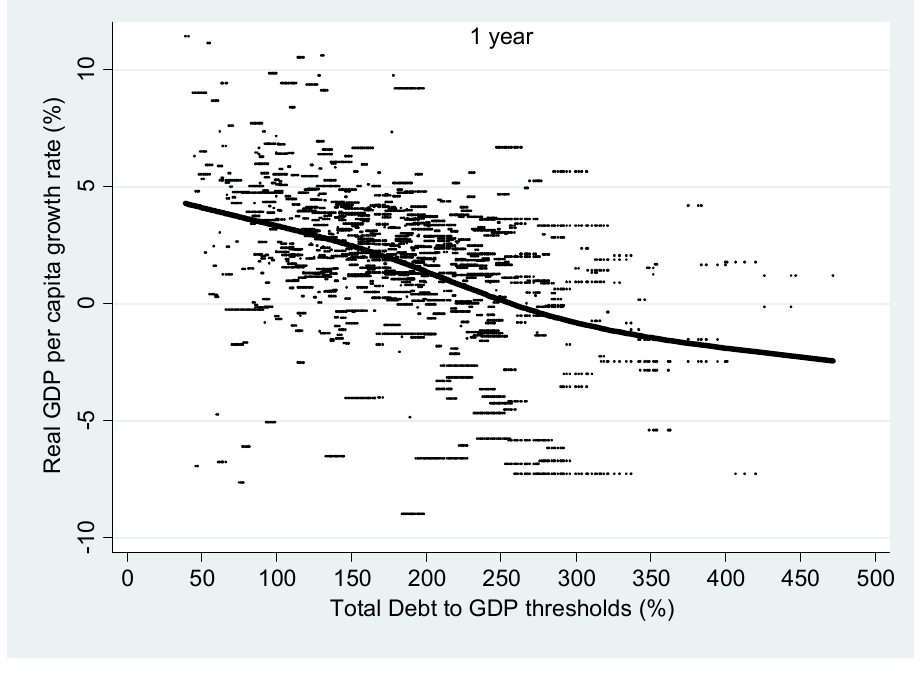
Figure 2 - Total debt and short-term economic